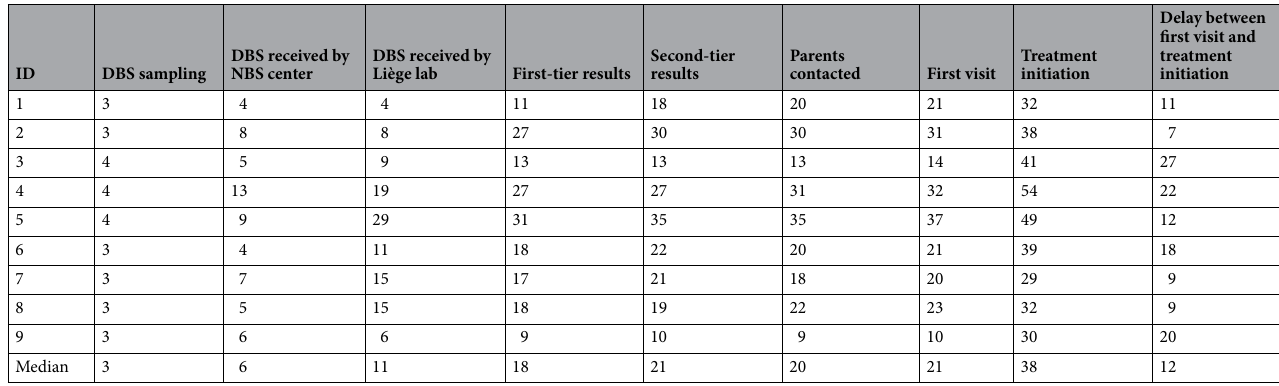
Table 1. Screening and diagnostic timeline (in post-natal days) for SMA patients identified by